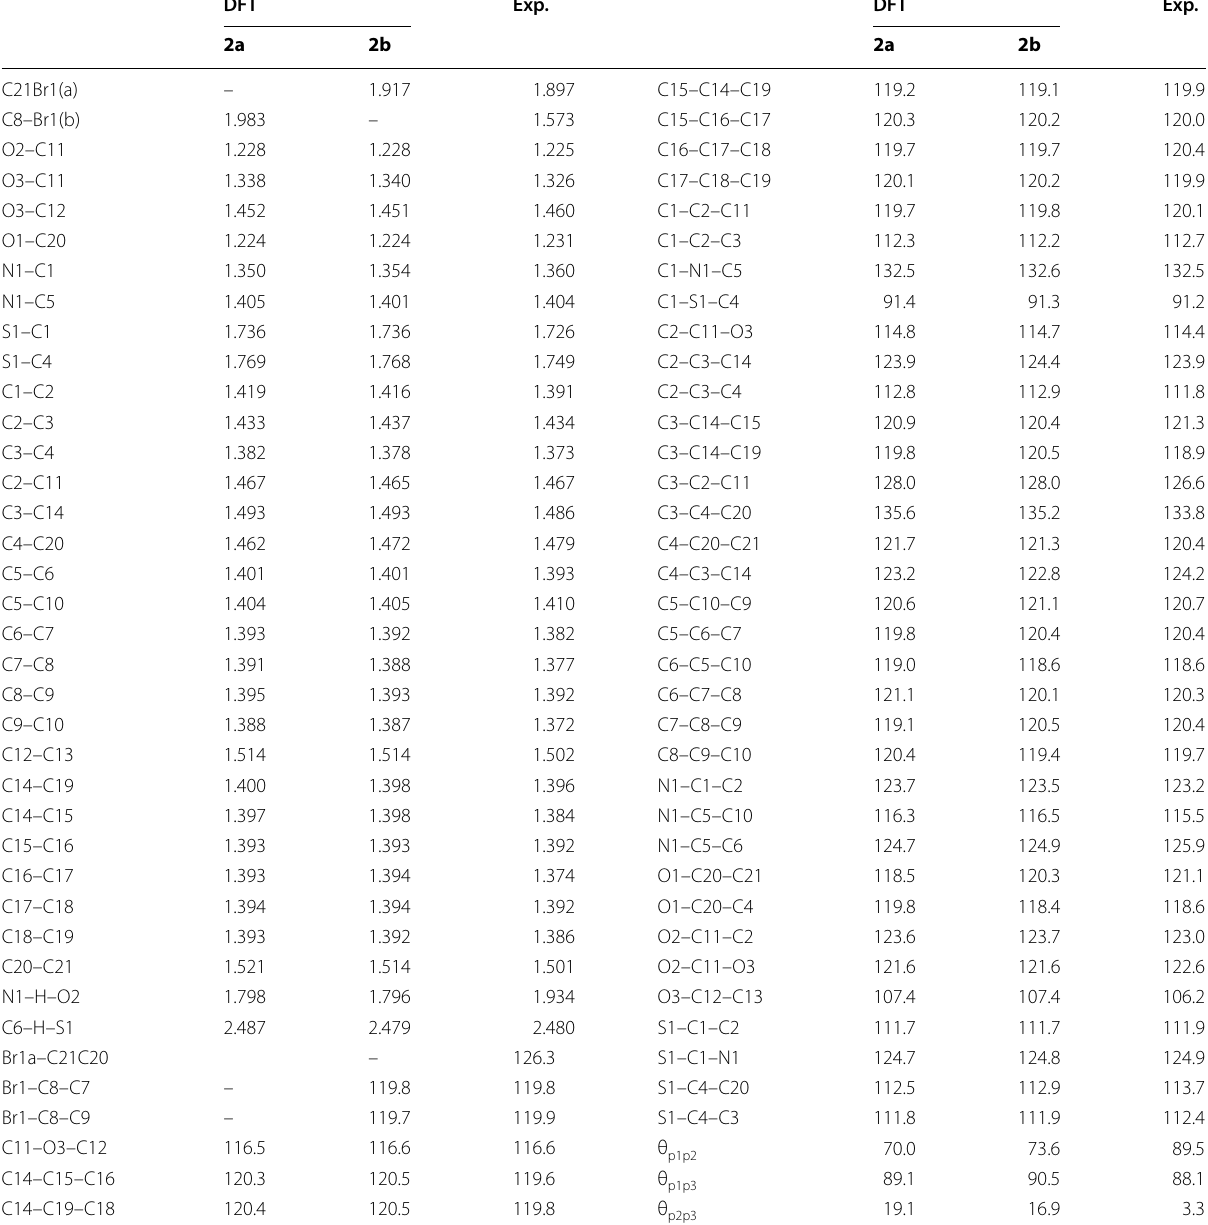
Table 3 The geometric parameters of both disorders, 2a and 2b (calculated and